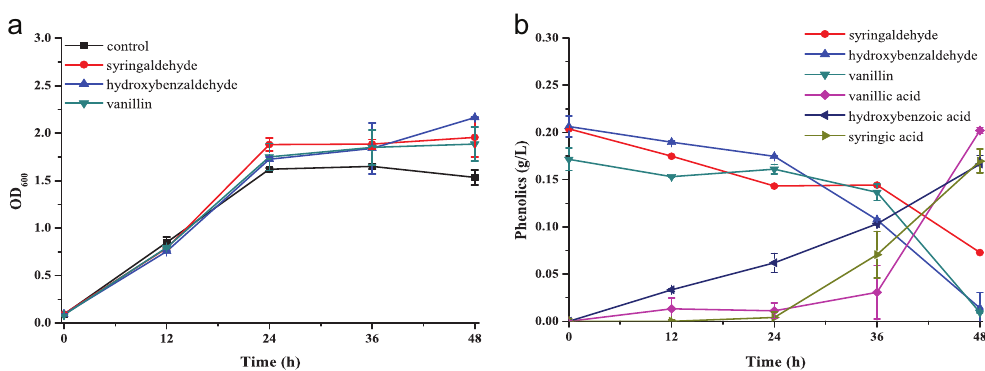
Figure 3. K. huakuii LAM0618 T transformed phenolic inhibitors into less toxic acids. ( a ) Growth curves of K. huakuii LAM0618 T in media containing syringaldehyde, hydroxybenzaldehyde, or vanillin (0.2 g/L) and yeast extract (3 g/L); and ( b ) degradation and their derivative acids curves of these phenolic inhibitors. All experiments were performed in duplicate and results are presented as mean ± SD. Error bars indicate SD.